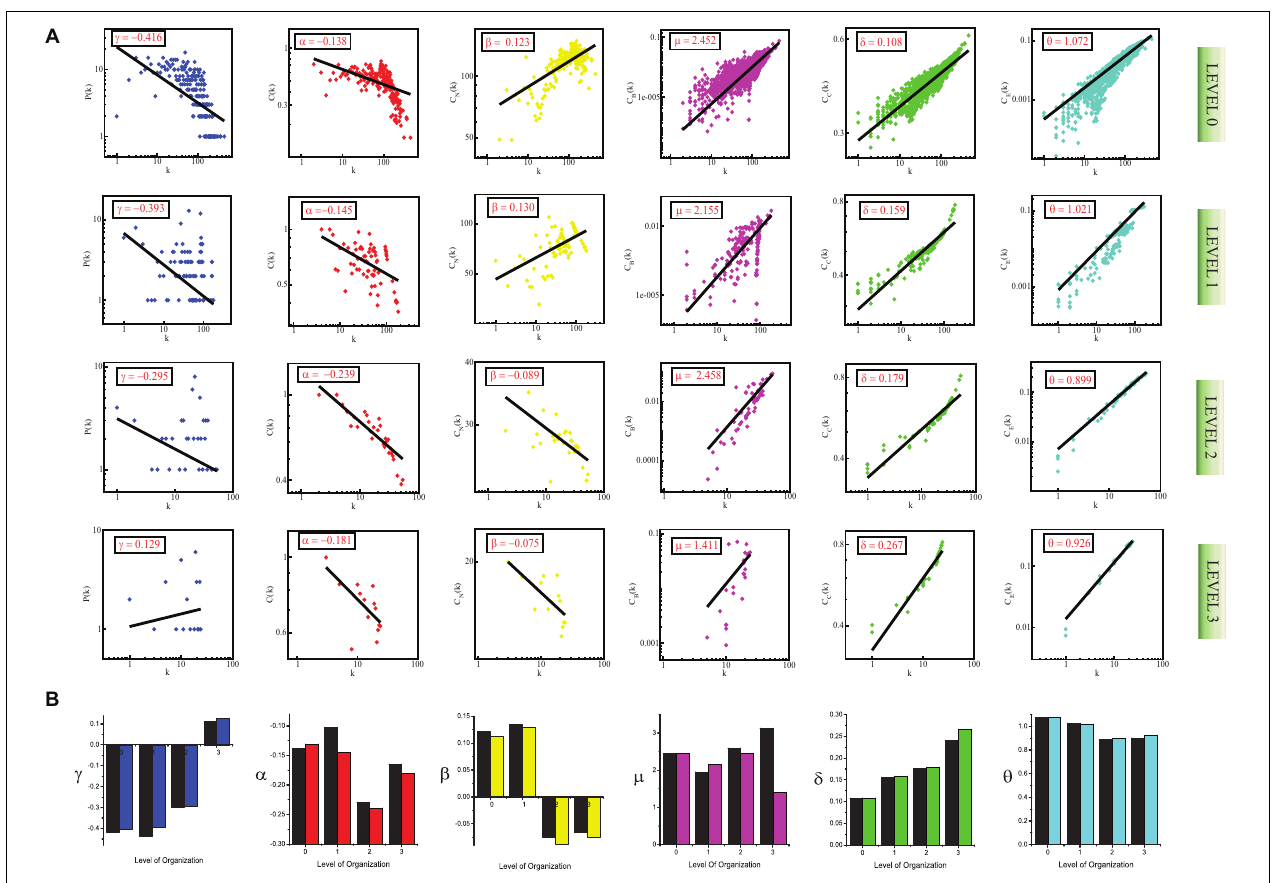
FIGURE 3 | (A) showing probability of degree distribution P ( k ), clustering coefficient C ( k ), neighborhood connectivity C N ( k ), betweenness centrality C B ( k ), closeness centrality C C ( k ), and eigenvector centrality C E ( k ) as a function of degree ( k ) for primary original network (level 0) and TRDMT1 motif knockout networks at different levels of the organization (level 1–3). (B) showing changes in the values of the topological properties’ exponents of the TRDMT1 motif knockout networks [colors corresponding to the ones used in the topological properties plots i.e., blue for P ( k ), red for C ( k ), yellow for C N ( k ), magenta for C B ( k ), green for C C ( k ) and turquoise for C E ( k )] compared with the topological properties’ exponents of the corresponding original networks (black) at different levels of the organization. γ , α , β , µ , δ , and O are the exponents of the degree distribution, clustering coefficient, neighborhood connectivity, betweenness centrality, closeness centrality, and eigenvector centrality,